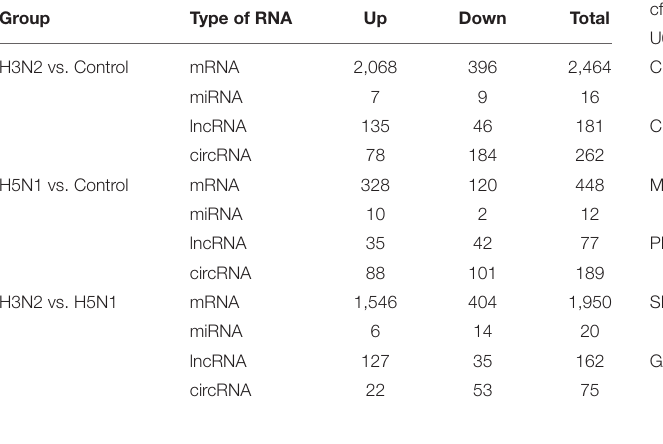
TABLE 1 | Differential expression profiles of mRNAs, miRNAs, lncRNAs, and circRNAs. Group Type of RNA Up Down